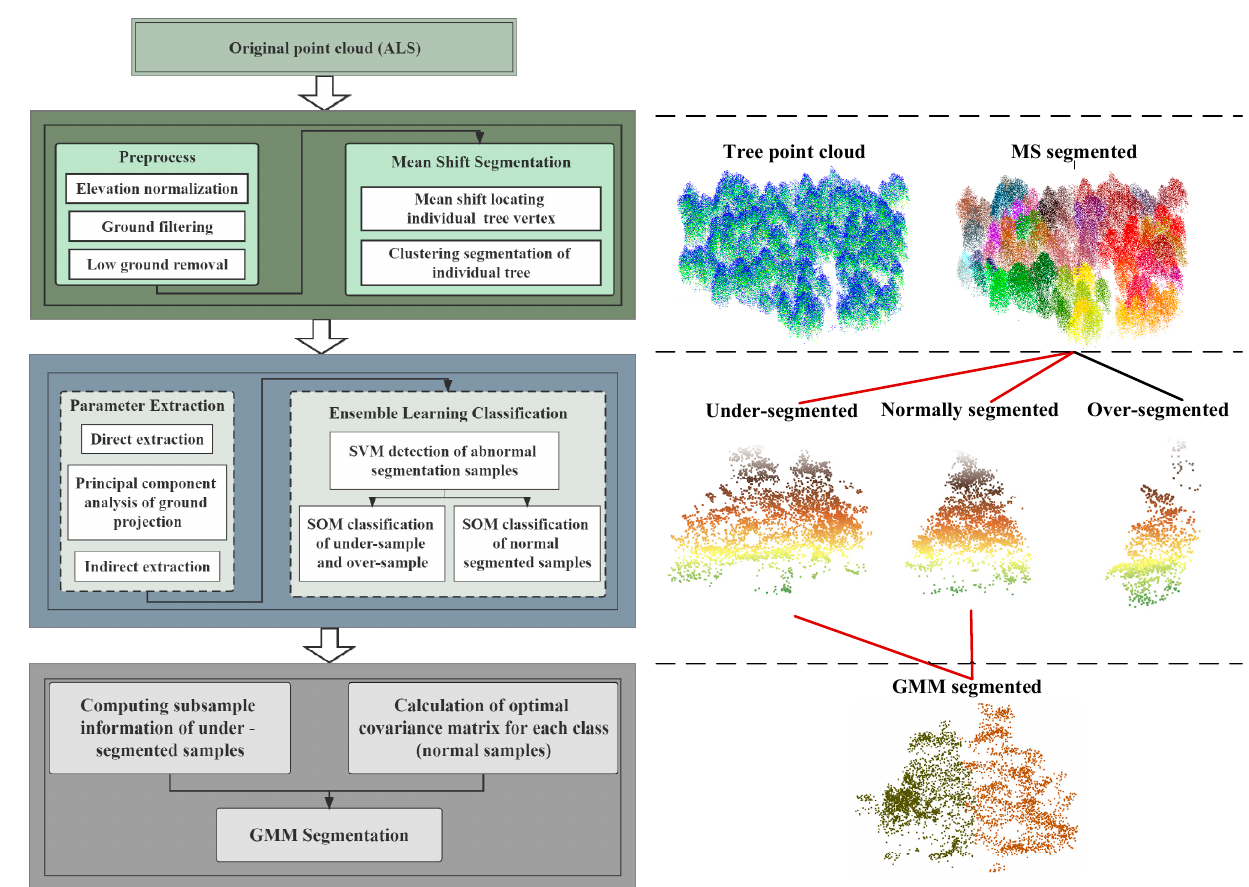
Figure 2. Flowchart of the ITS optimization algorithm.